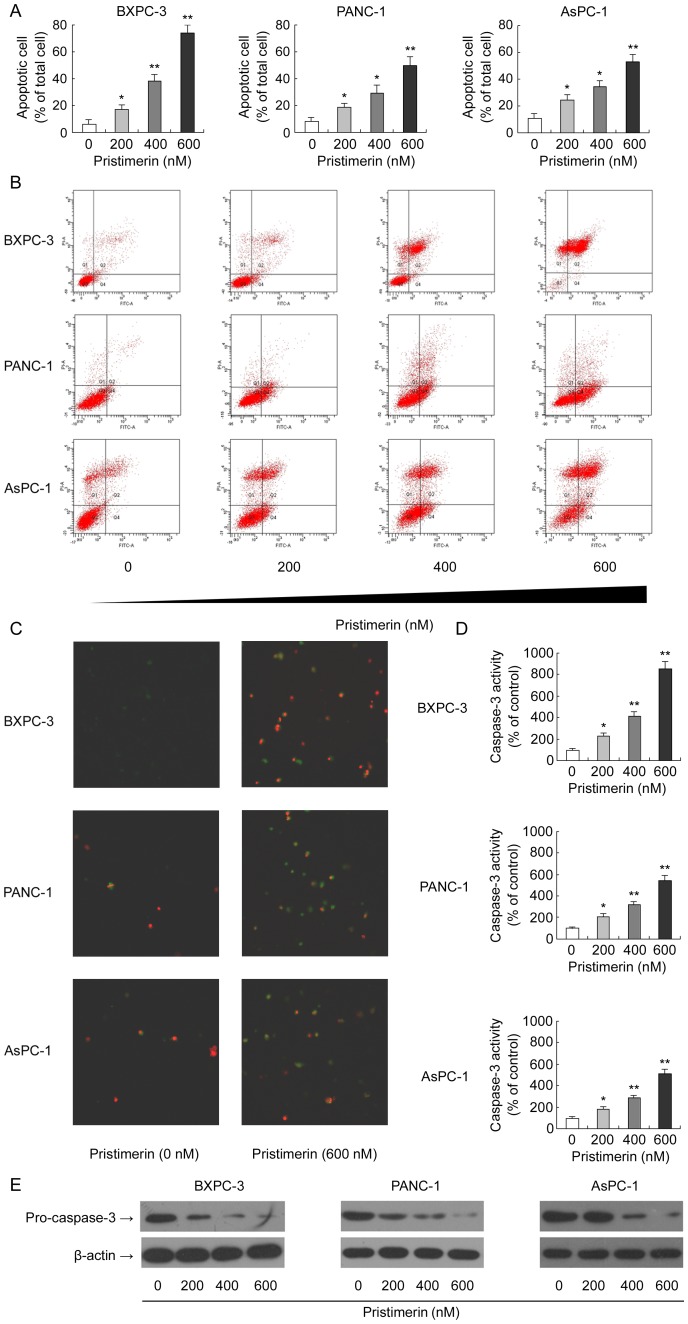
Effect of pristimerin on apoptosis induction in pancreatic cancer cells.(A) Effect of pristimerin on apoptosis induction assessed by Annexin V/PI method using flow cytometry. BxPC-3, PANC-1 and AsPC-1 cells were cultured in complete medium and treated with either pristimerin (200, 400 or 600 nM) or DMSO (control) for 48 h. Apoptosis rate was determined by flow cytometry on annexin V-FITC. (B) Representative dot-plots from cytometrically illustrating apoptotic status in BxPC-3 (upper panel), PANC-1 (middle panel) and AsPC-1 (lower panel) cells. (C) Effect of pristimerin on apoptosis induction assessed by fluorescence microscopy. Cells were also viewed under a fluorescence microscopy. Representative photographs were taken from Annexin V/PI-stained pancreatic cancer cells under certain treatment. (D) Effect of pristimerin on apoptosis induction assessed by caspase-3 activity assay. Cell lysates were assayed for caspase-3 activity as described in “Materials and methods”. (E) Effect of pristimerin on cleavage of caspase-3. As detailed in Materials and Methods, pancreatic cancer cells (BxPC-3, PANC-1 and AsPC-1) were treated with either pristimerin (200, 400 or 600 nM) or DMSO (control) for 48 h and then harvested. Total cell lysates were prepared and subjected to SDS-PAGE followed by Western blot analysis. β-actin was detected as protein loading control. The immunoblots shown here are representative of at least three independent experiments with similar results. *P<0.05, compared with control. **P<0.01, compared with control.